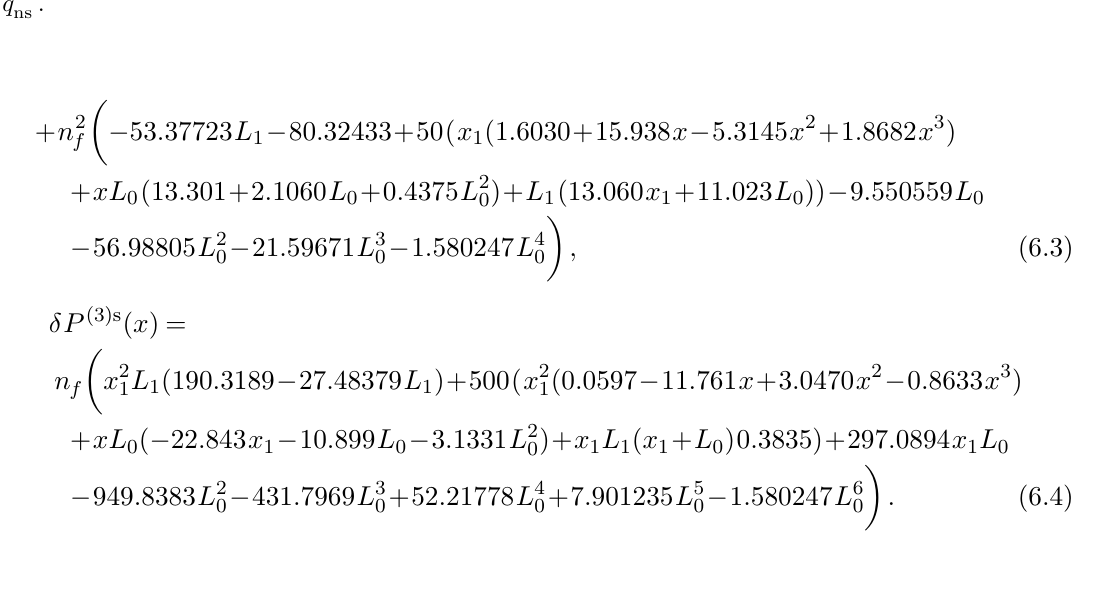
Figure 11 . As (cid:12)gure 10, but for the scale derivative of quark minus anti-quark